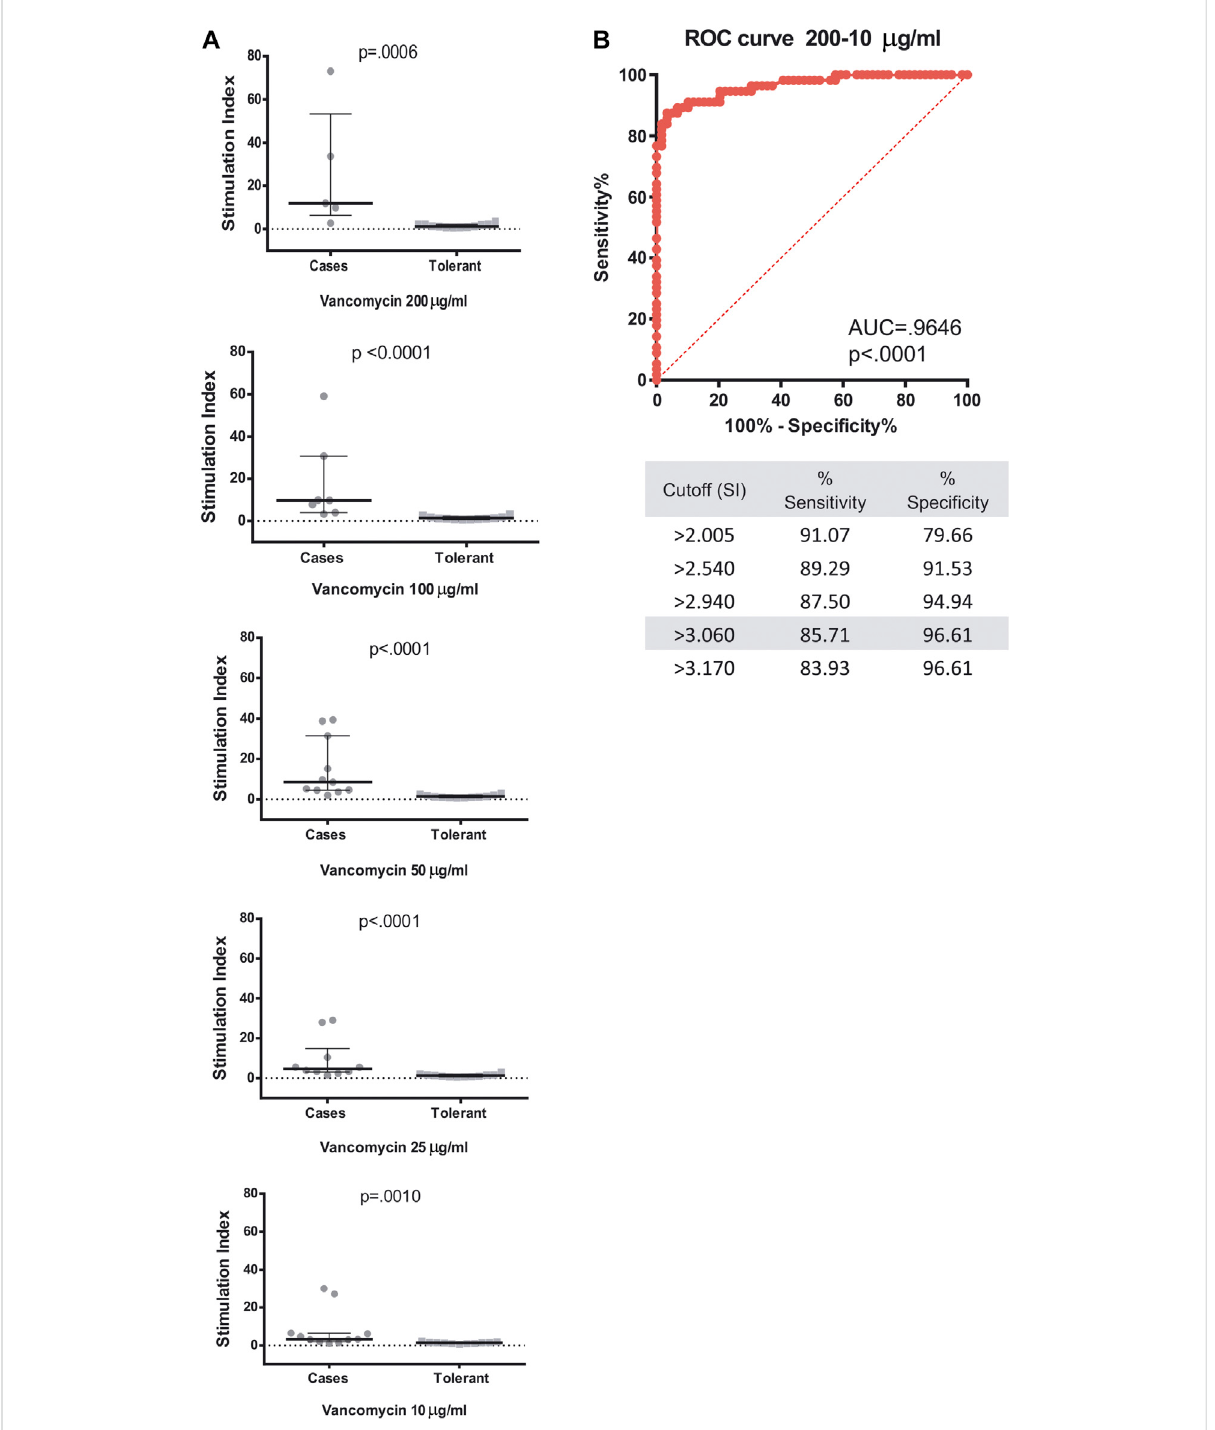
FIGURE 1 LTT results and ROC curveanalysis ofLTT to vancomycin. (A) PBMCsfrom 12 patients with adiagnostic of DRESSand vancomycin involvement or from 12 vancomycin-tolerant control donors were isolated and cultured in vitro with 10, 25, 50, 100, or 200 μ g/ml of vancomycin. Stimulation indices were calculated as described in the methods section. Median and interquartile ranges are shown. Mann – Whitney U test was applied for statistical analysis. (B) ROC curve analysis, sensitivity, and speci fi city of grouped results for the fi ve concentrations